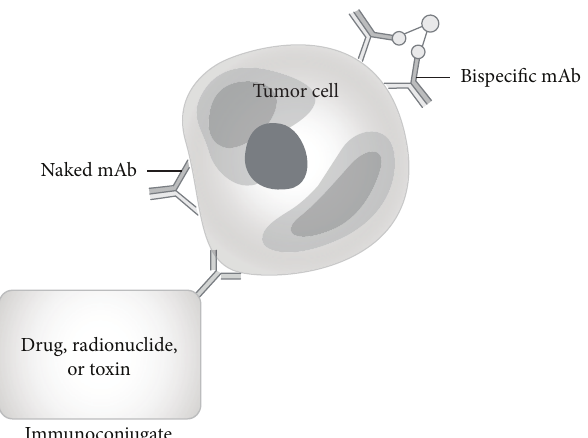
Figure 1: Different mechanisms of tumor cell killing by monoclonal antibody therapy. Monoclonal antibodies exhibit tumor cell cyto- toxicity by targeting a specific tumor antigen. Immunoconjugates are monoclonal antibodies conjugated to drugs, toxins (immuno- toxins), or radionuclides. mAb: monoclonal